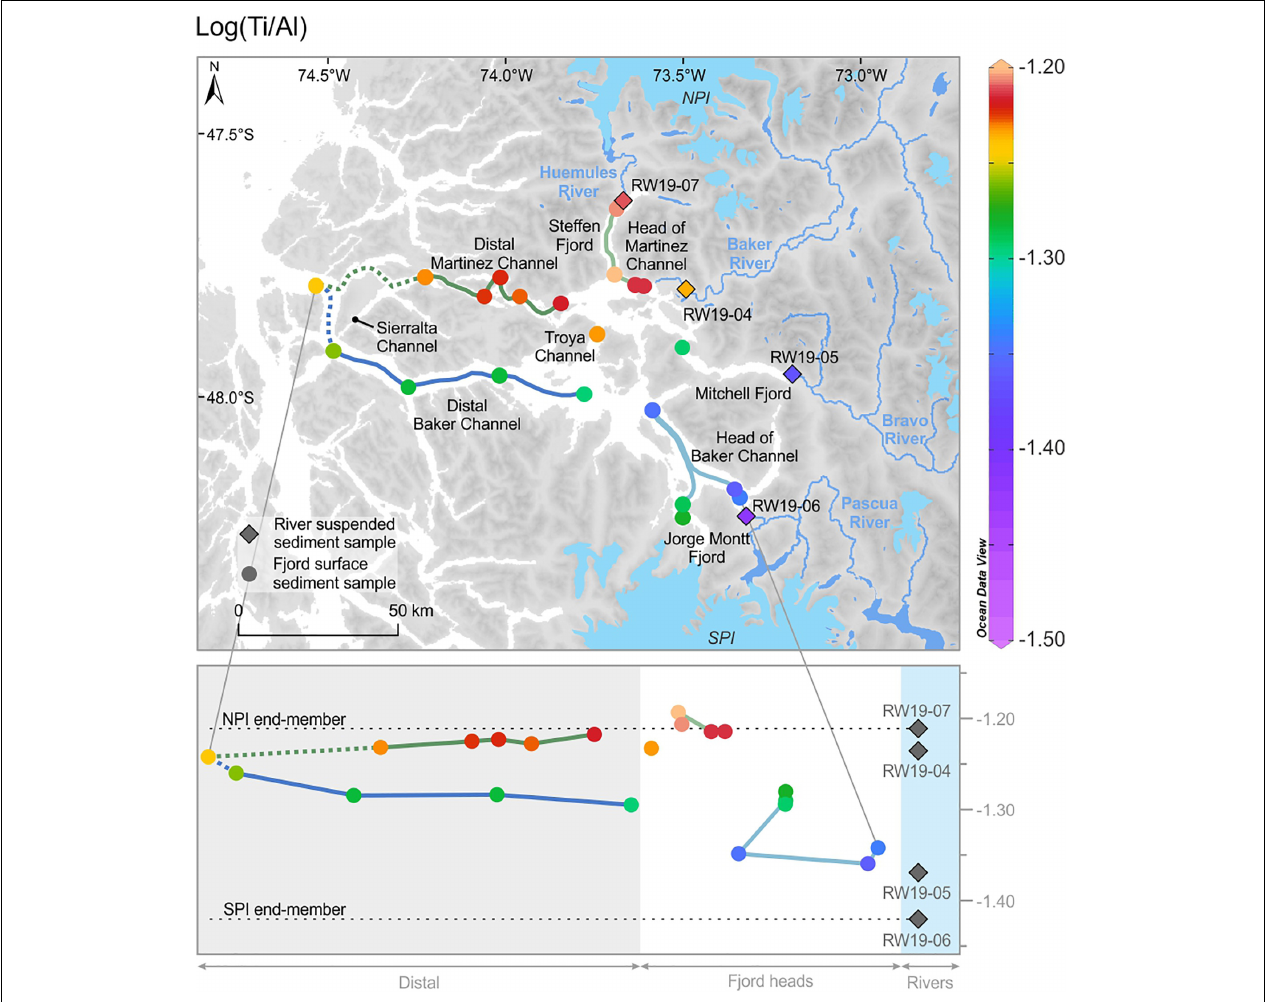
FIGURE 7 | Spatial variability in log(Ti/Al) of the fjord and river sediment samples. The colored lines between the fjord samples represent the four subsets with n > 1 ( Figure 2 ). In the bottom panel, the fjord samples are plotted according to longitude. Error bars are smaller than the size of the symbols. The provenance end-members are defined by the RW19-07 (NPI) and RW19-06 (SPI) river sediment